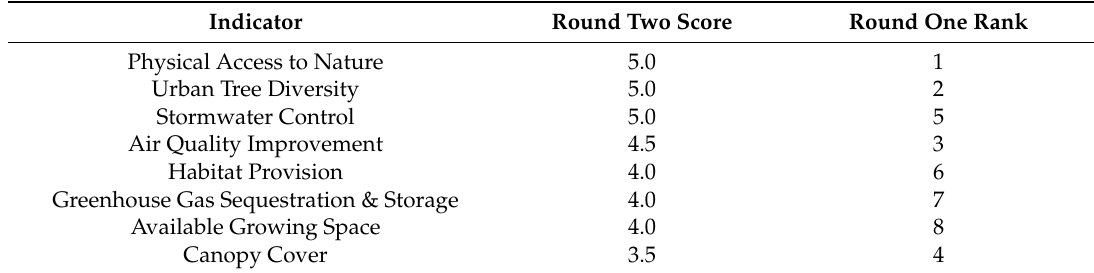
Table 4. Practitioner results after Round